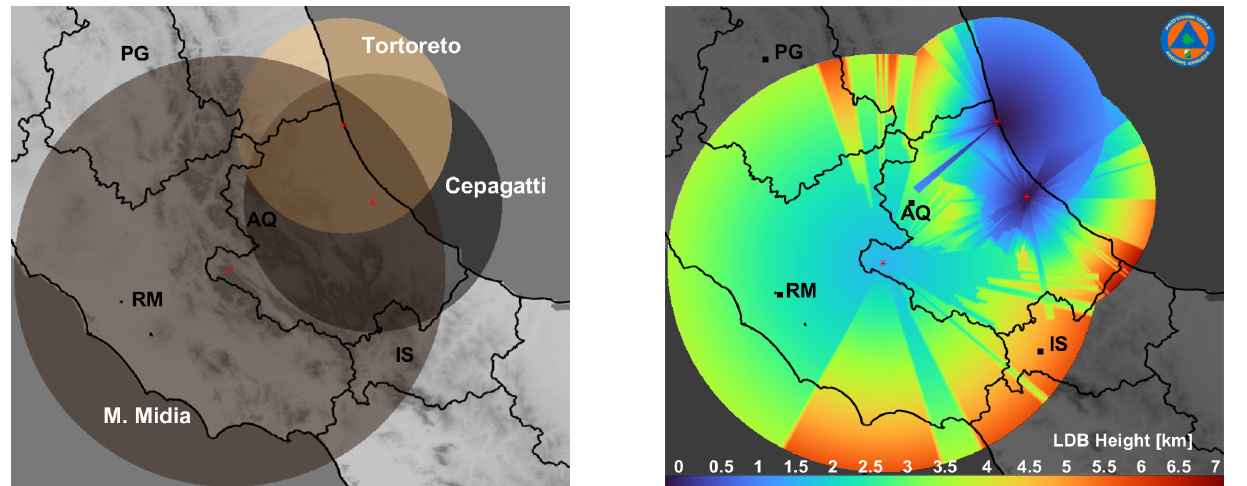
Figure 5. ( Left panel ) The Abruzzo network composite domain with the maximum coverage area chosen for each radar system (120 km for C-band MM, 80 km for X-band CE, and 60 km for X-band TO). ( Right panel ) Map of the minimum LDB (lowest detectable bin) height, mosaicked from the corresponding maps of the three weather radars represented by the operational maximum range (see the left panel ).